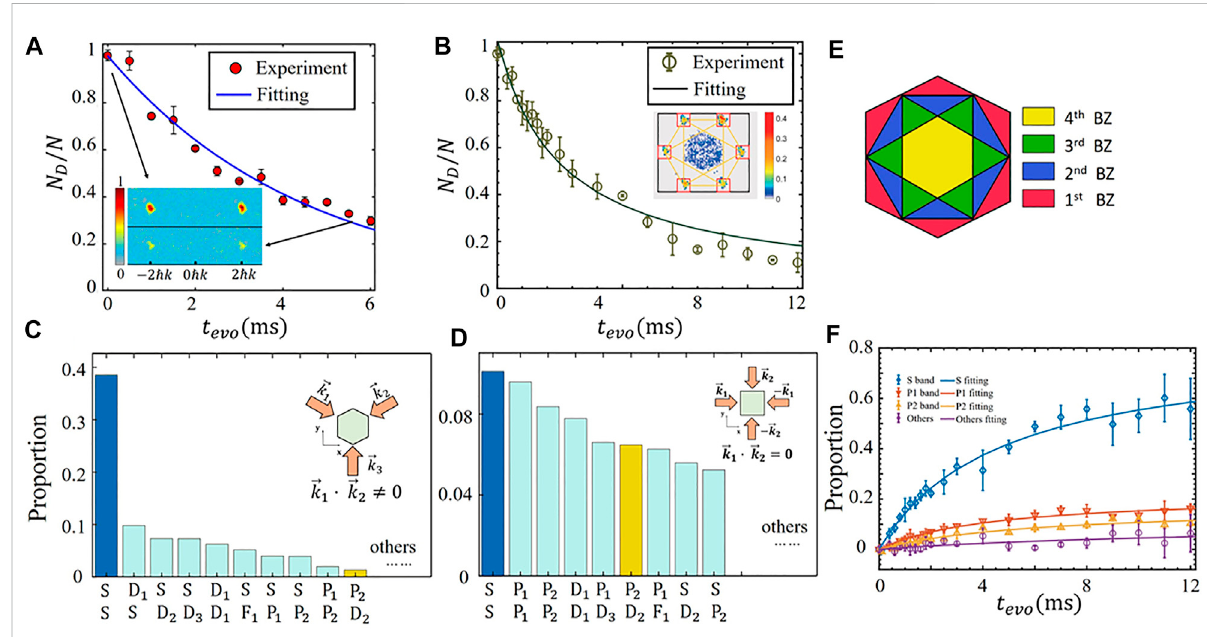
FIGURE 12 (A) The proportion of D-band over theevolution time in1D lattice. (B) The proportion of the fi rst D-band (D1-band) in the triangular lattice. The proportions of several main scattering channels are shown in (C) (triangular lattice) and (D) (square lattice). The inserts show the diagram of a square optical lattice and triangular optical lattice. (E) Schematic diagram of the fi rst four Brillouin zones of a triangular optical lattice. Yellow, green, blue, and red areas represent 1 st , 2 nd , 3 rd , 4 th BZ, respectively. (F) The atomic proportion in S (P1, P2 band, and others), of which the solid lines with the same color fi t